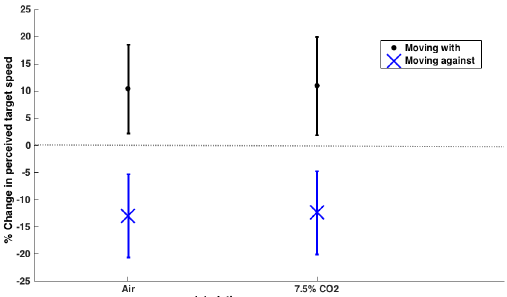
Fig 9. Mean ( ± SD) percentage change in perceived speed for the two inhalations conditions (N = 15 participants). The dynamic texture causes the target to be perceived as moving faster or slower depending on the direction of the camouflage movement. This appears to be robust to stressful situations as the effect is similar for both normal air and 7.5% CO 2